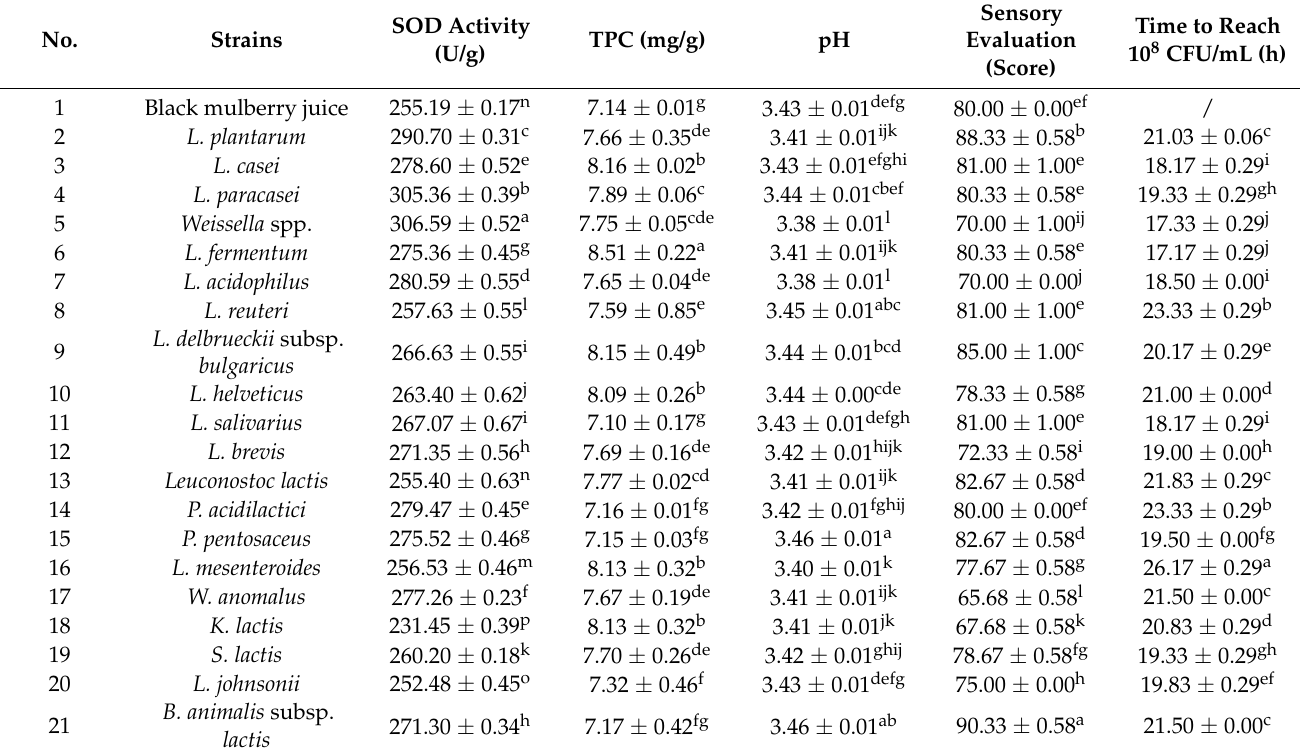
Table 5. Physicochemical properties of MBJ fermented by twenty